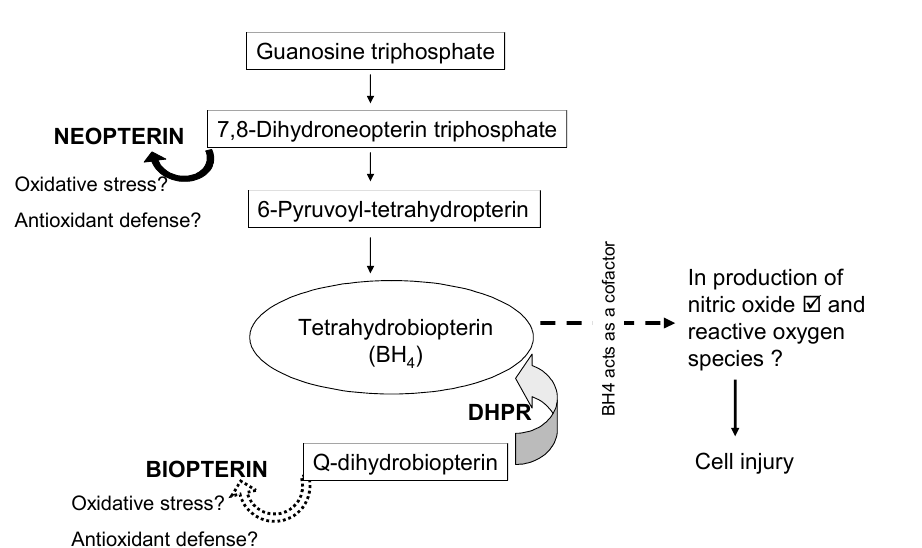
Figure 1. The relationship between unconjugated pteridines such as neopterin, biopterin, and 5,6,7,8-tetrahydro- biopterin and related enzyme, dihydropteridine reductase (DHPR). The question marks represent the dual effects of neopterin and biopterin on oxidative stress as described in the text.